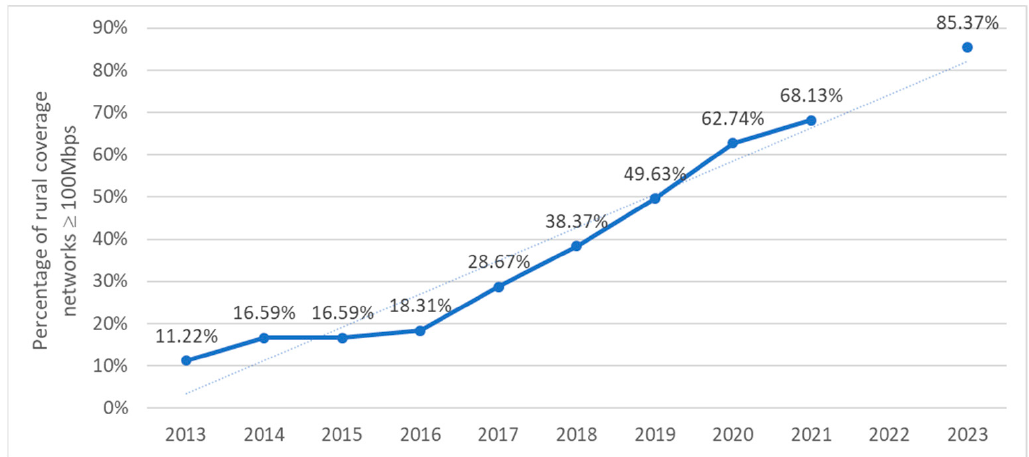
Figure 4. Evolution of coverage at 100Mbps [55].